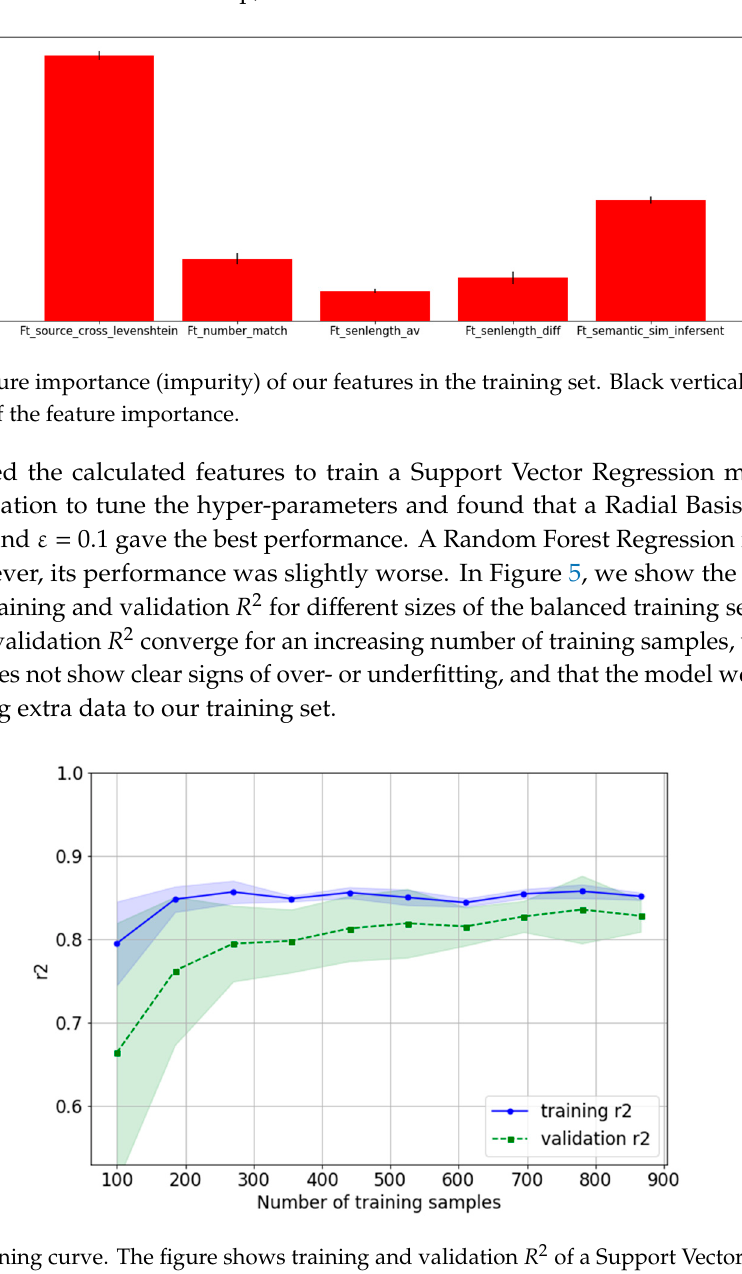
Figure 5. Learning curve. The figure shows training and validation R 2 of a Support Vector Regression model for different sizes of the train set using 5-fold cross-validation.